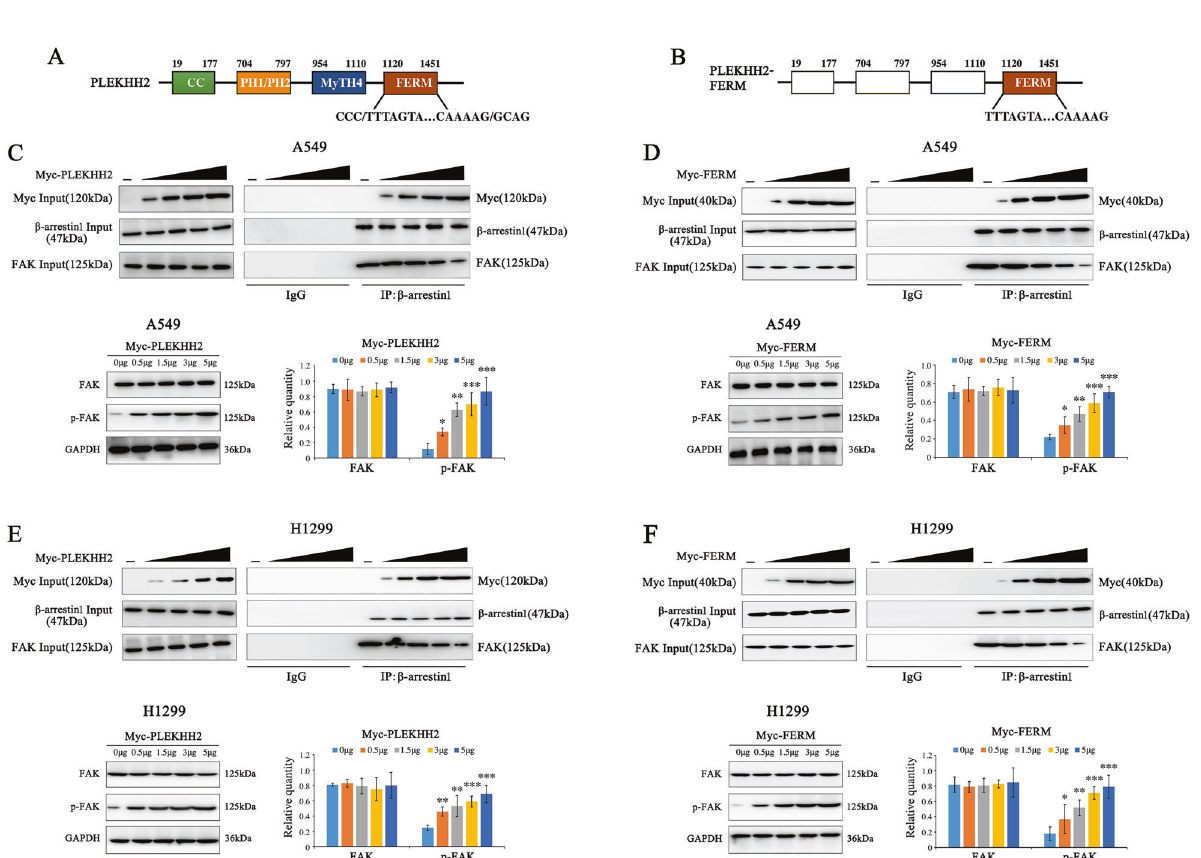
Fig. 7 PLEKHH2 binds β -arrestin1 through its FERM domain, competitively inhibits β -arrestin1 interaction with FAK, and promotes FAK phosphorylation. A, B Schematic diagram of PLEKHH2 and PLEKHH2-FERM splicing mutants. Compared to the full-length PLEKHH2, PLEKHH2-FERM only has the isolated FERM domain. C PLEKHH2 overexpression attenuates the binding between β -arrestin1 and FAK. In the A549 cell line, the PLEKHH2 plasmid (0 μ g, 0.5 μ g, 1.5 μ g, 3 μ g, and 5 μ g) was transfected in a dose-dependent manner. β -arrestin1 was used for immunoprecipitation. The binding of β -arrestin1 to PLEKHH2 gradually increased, while the association of β -arrestin1 and FAK was gradually decreased (Statistical analysis is shown in Supplementary Fig. 7E). Moreover, PLEKHH2 overexpression increased FAK phosphorylation gradually. D FERM domain (0 μ g, 0.5 μ g, 1.5 μ g, 3 μ g, and 5 μ g) was transfected into A549 cells. It exhibited gradually increase in binding with β -arrestin1 and gradually decrease in binding with β -arrestin1 and FAK (Statistical analysis is shown in Supplementary Fig. 7F). It also promoted p-FAK level in a dose gradient manner. Both PLEKHH2 and its FERM had no effect on FAK expression. Similar results are seen in H1299 cell line ( E, F , Supplementary Fig. 7G and H). Increased p-FAK was compared to the cells with no transfection. P < 0.05 indicates statistical signi fi cance, * P < 0.05, ** P < 0.01, *** P <